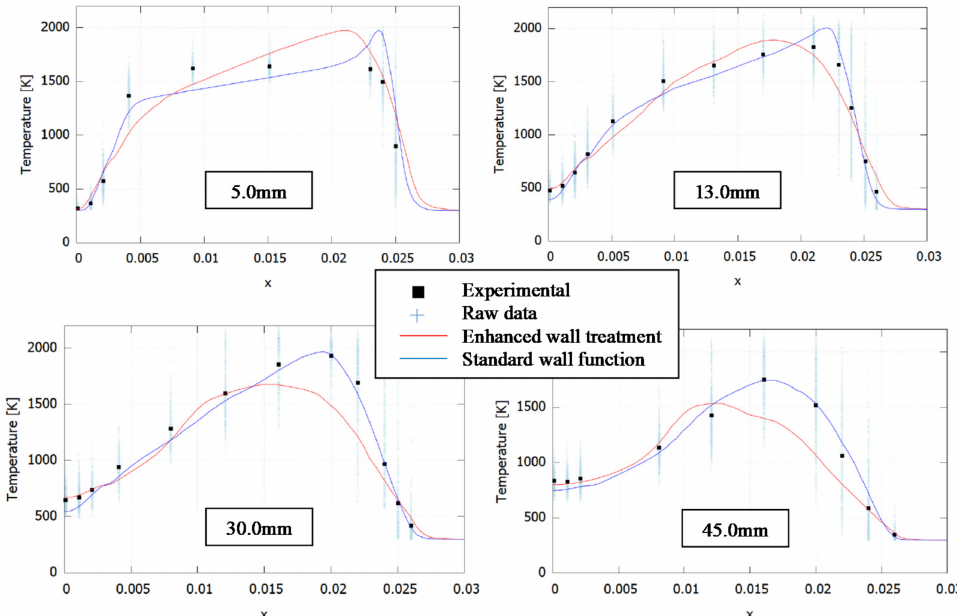
Figure 14. Temperature profiles at increasing axial distances. FGM/CRECK. Complete experimental data available at reference [15].